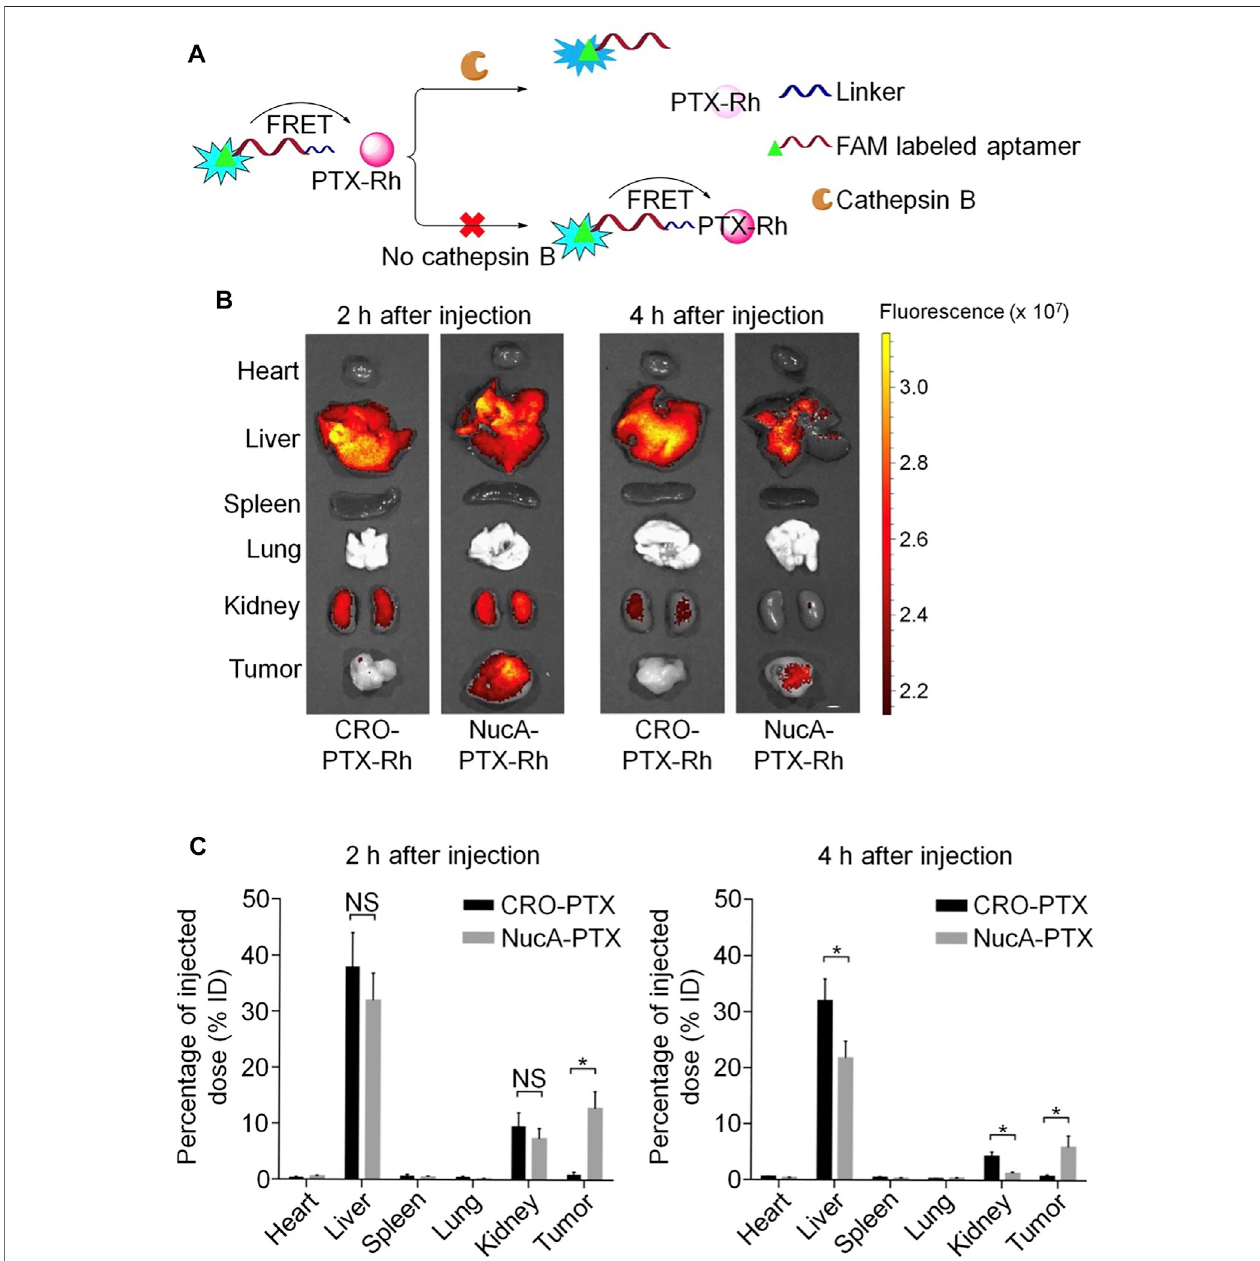
FIGURE 8 | Aptamer-paclitaxel conjugates for targeted therapy of ovarian cancer. (A) Schematic illustration of the use of FRET in FAM-NucA-PTX-Rh for tracking the rupture of the cathepsin B-labile linker. (B) Distribution of conjugated PTX-Rh in tumors and major viscera after intravenous injection of NucA-PTX-Rh or CRO-PTX- Rh. (C) Rhodamine fl uorescence intensity of each tumor and